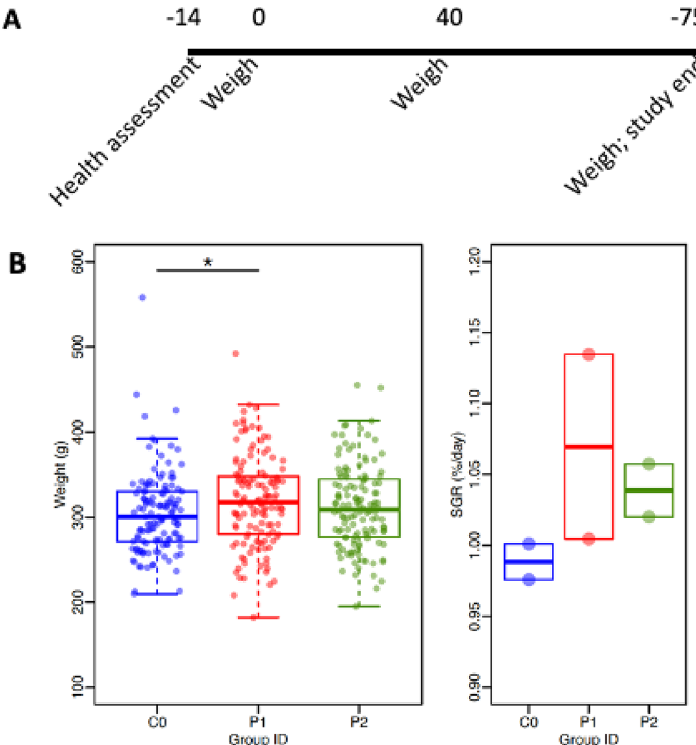
Figure 4. Effect of probiotic supplementation on the weights of salmon following daily administration in feed for 75 days in saltwater. ( A ) Timeline of experimental events. ( B ) Mean body weights ± standard error as well as specific growth rate (SGR, %/day) for each group following daily administration of the respective probiotic candidates in feed for 75 days. *P = 0.041 for Co vs P1, ANOVA with Dunnett’s test (n = 64). P1, Test